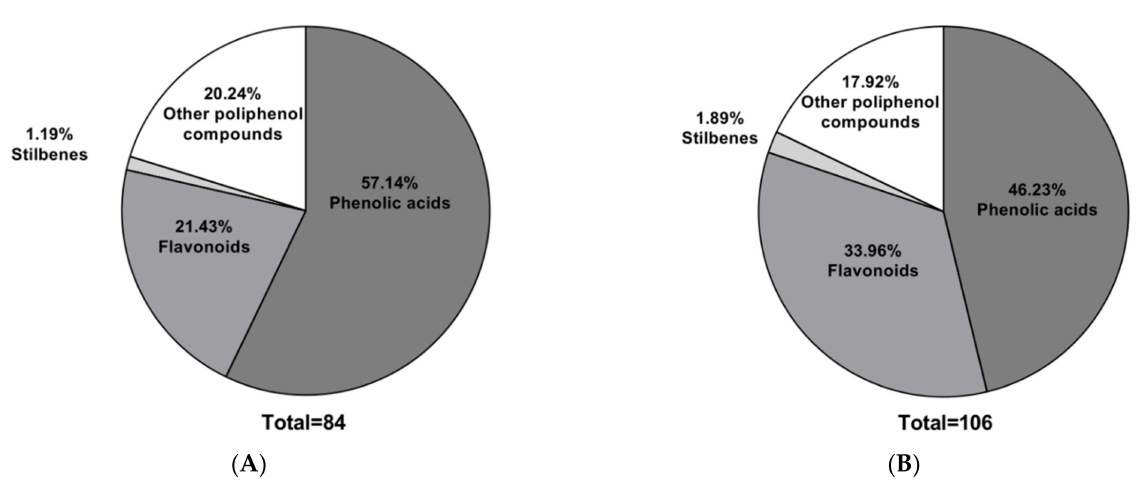
Figure 1. Relative distribution n of polyphenol families in MS extracts from ( A ) RAE, ( B ) HAE (unit: %).